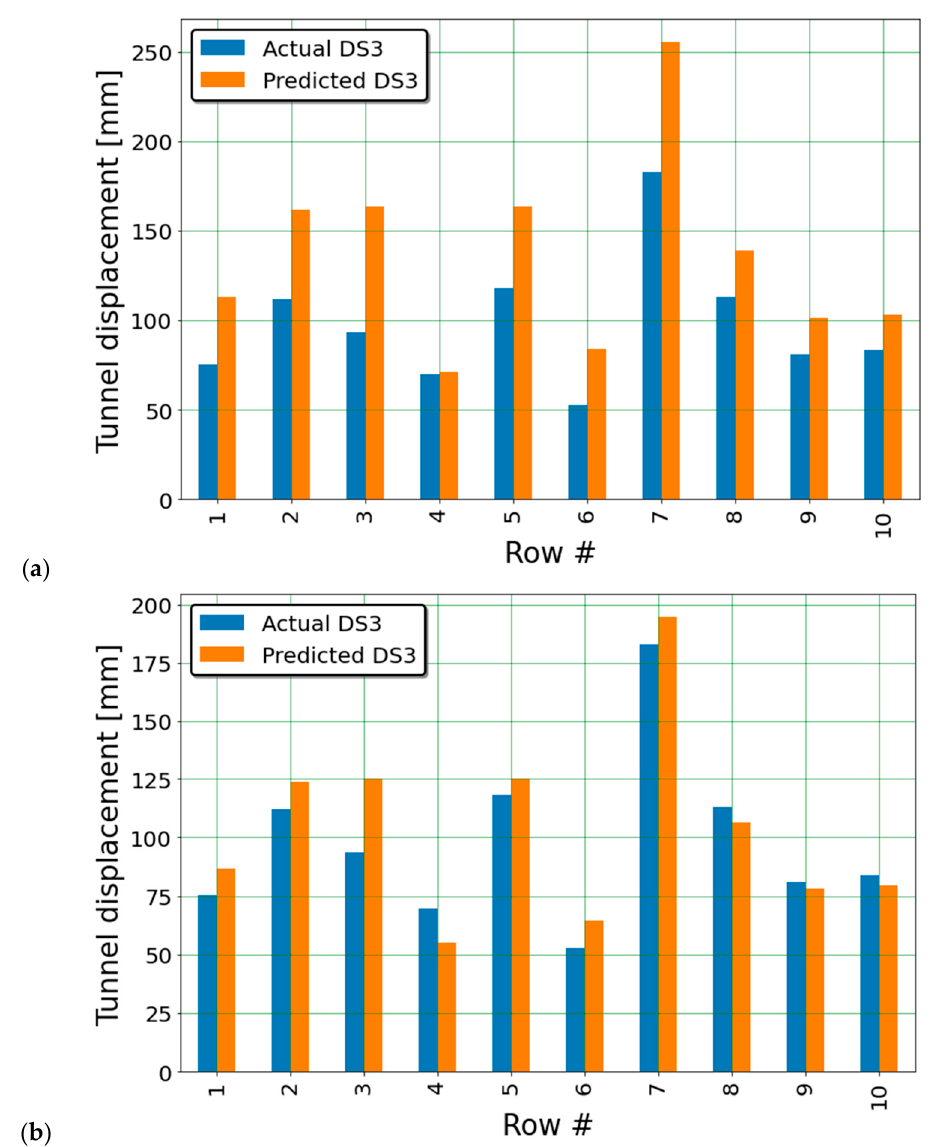
Figure 7. Prediction vs. actual tunnel displacements for DS3 with NSD = 5% computed with ( a ) NN1, i.e., no transfer learning, and ( b ) NNT, i.e., with transfer learning.